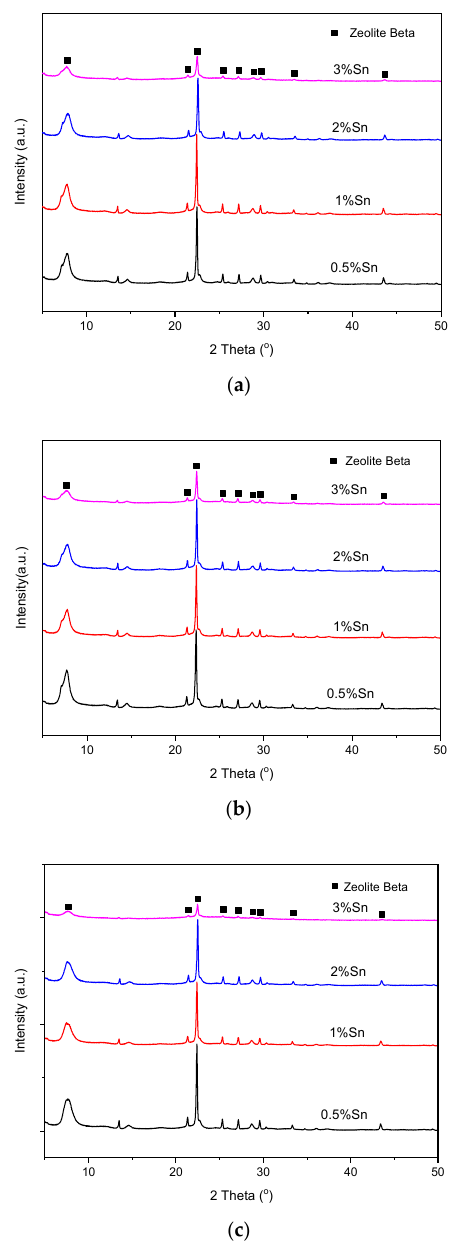
peak of the Au (200) crystal plane. The Au and CuO were just not affected by the prepa- Figure 1. The XRD patterns of Sn- β -Cl ( a ), Sn- β -OXS ( b ), and Sn- β -DBTM ( c ). ration process. The XRD patterns of Au/CuO-Sn- β with different Au contents were shown in Figure 2. The characteristic diffraction peaks for β zeolite were maintained after the combination of Au/CuO and Sn- β . The preparation process did not damage the structure of Sn- β zeo- lite. The characteristic diffraction peaks of Au and CuO could be observed by partially enlarging the XRD patterns. The characteristic diffraction peaks located at 2 θ = 35.5°, 38.7° and 48.1° was ascribed to the diffraction peaks of CuO (11–1), (11–1) and (20–2) crystal planes. The characteristic diffraction peak located at 2 θ = 44.4° belonged to the diffraction